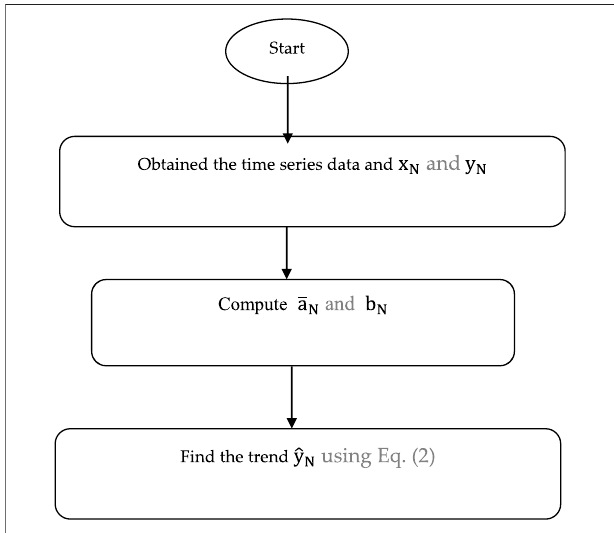
FIGURE 1 | The frame diagram of the proposed time series method.